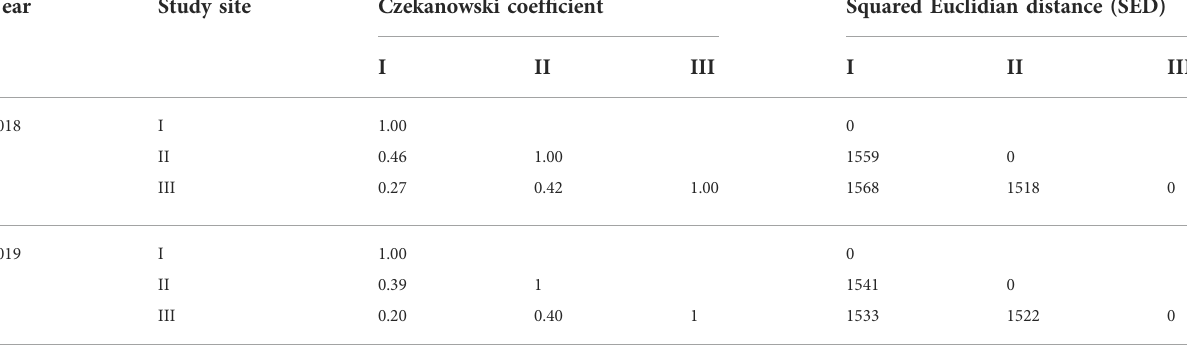
TABLE 3 Czekanowski coef fi cient and squared Euclidean distance (SED) values of three study sites. I: Chattogram, II: Satkhira, and III: